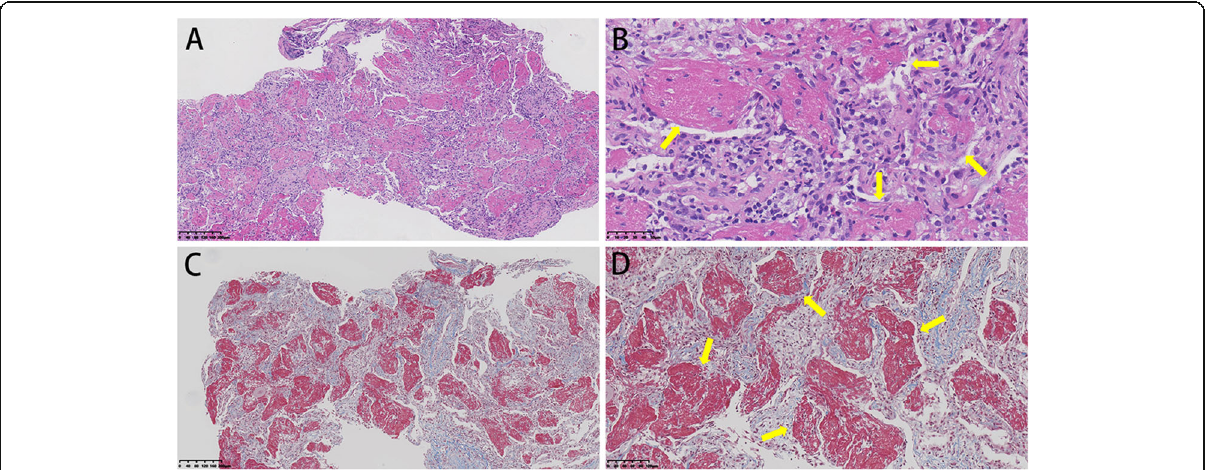
Fig. 2 Histologic findings of case 1 on lung biopsy. Hematoxylin and eosin stain ( A , ×100) ( B , ×200) showed alveoli were filled with fibrinous exudate (arrows) without pulmonary hyaline membrane, the alveolar septum was thickened and infiltrated with a few lymphocytes, which were consistent with AFOP. Masson ’ s trichrome stain ( C , ×100) ( D , ×200) showed alveoli cavities were filled with fibrinous exudates (arrows)